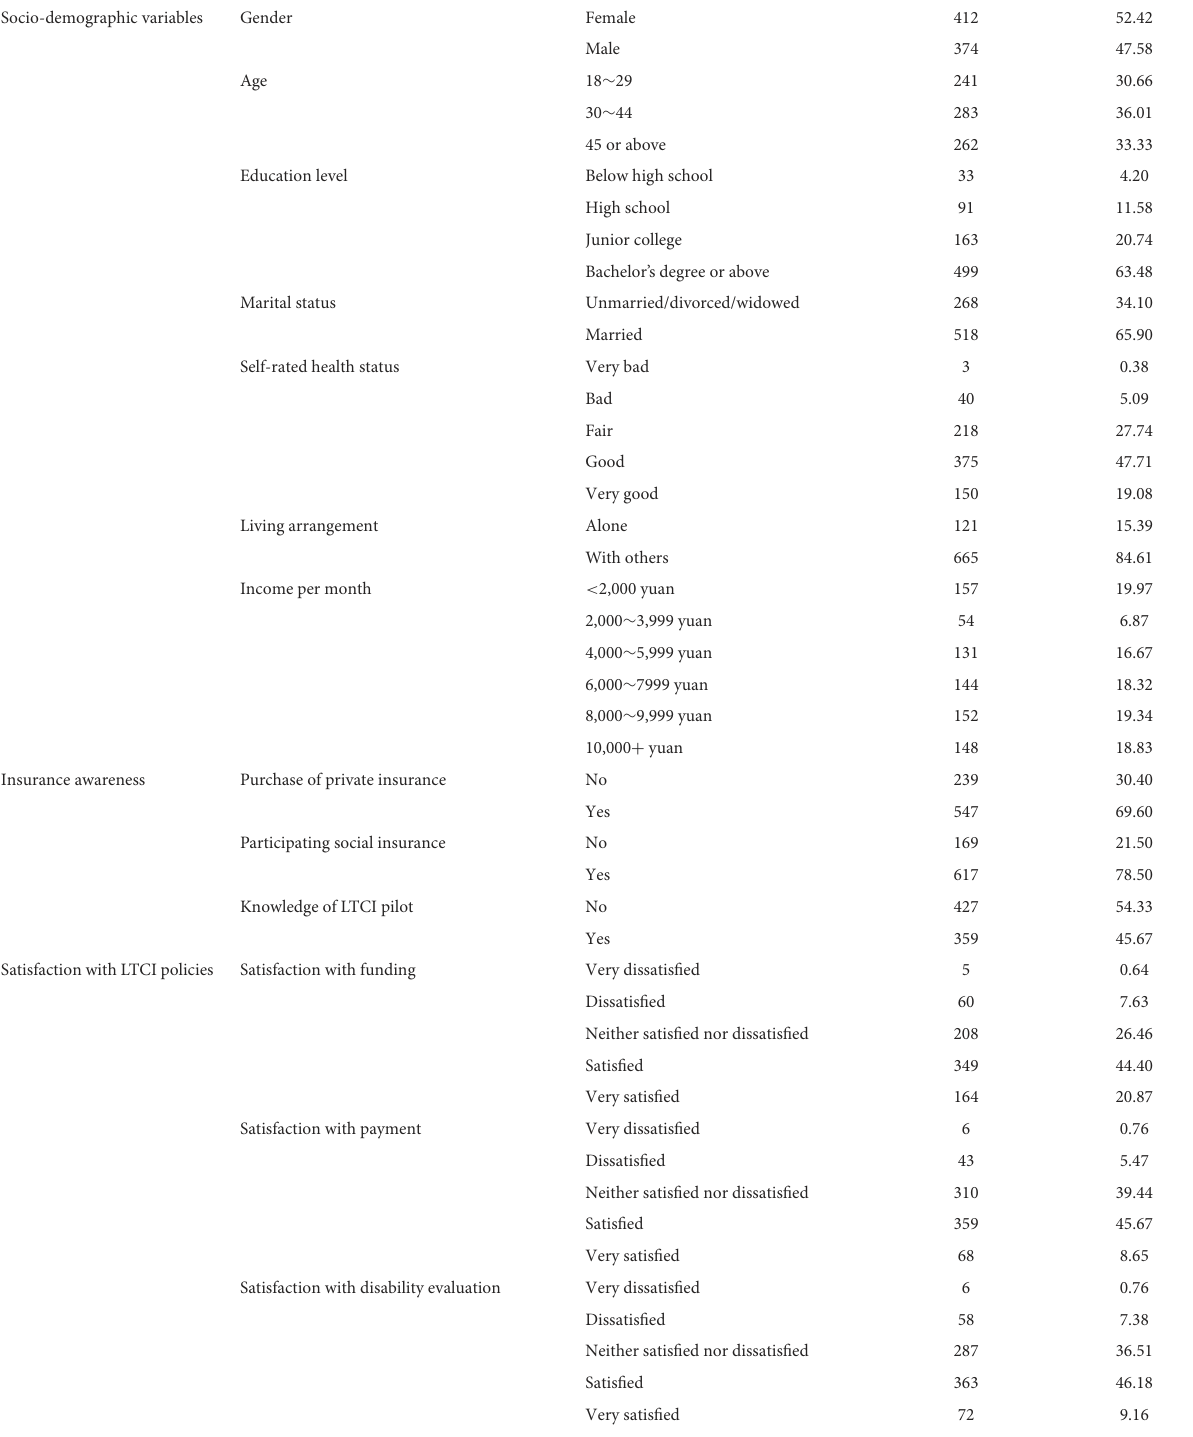
TABLE 1 Descriptive statistics of the survey sample ( N =